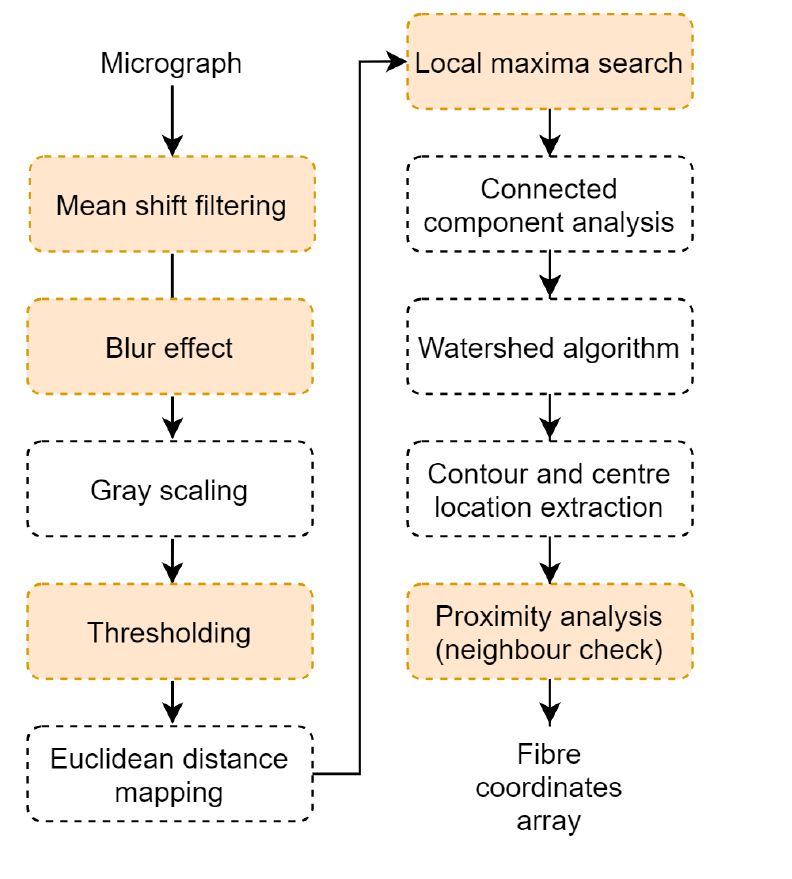
Figure 2. Image analysis steps for extracting fibre coordinates from a micrograph (coloured boxes are discussed in Section